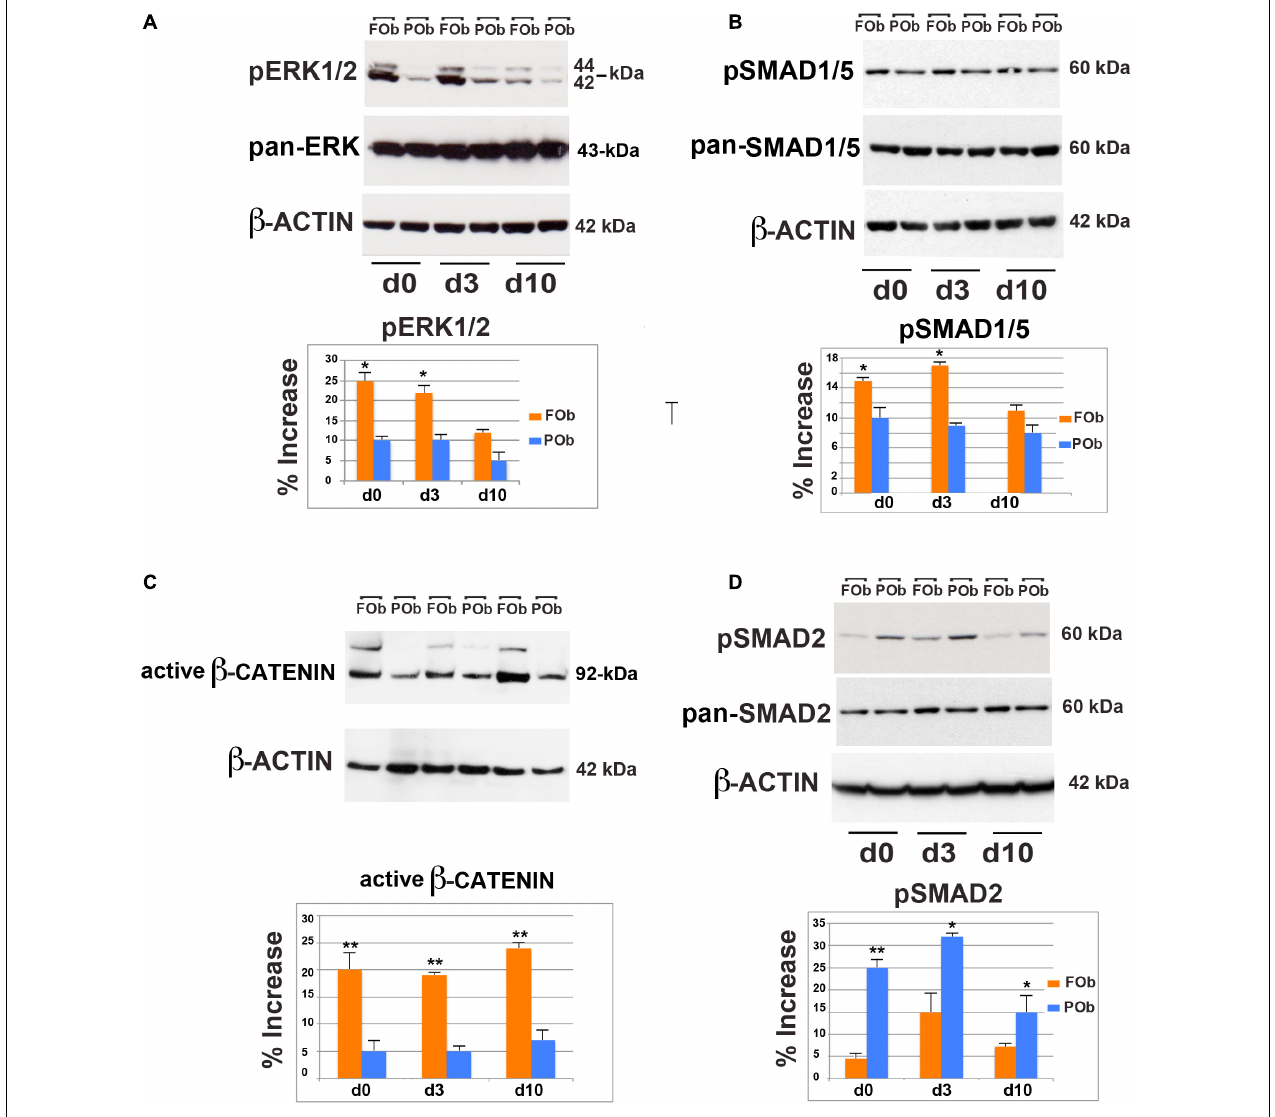
FIGURE 3 | Integration of multiple pro-osteogenic signaling pathways defines distinct active hFOb and hPOb. (A) Time-course immuno-detection of phospho-ERK1/2 (pERK1/2) in hFOb and hPOb undergoing to osteogenic differentiation showing enhanced active pERK overtime in hFOb in comparison to hPOb. Pan-ERK and β -ACTIN antibody probing the same membrane were used as internal controls for equal loading and transfer of the samples. (Bottom panel) , histogram represents the densitometric analysis of electrophoresis bands using the Image J program; the relative intensities of bands were normalized to their respective loading control and set as 100%. (B) Time-course immuno-detection of phospho-SMAD1/5 (pSMAD1/5) proteins in hFOb and hPOb undergoing osteogenic differentiation showing increased protein levels in hFOb than hPOb. Immunoblotting with pan-SMAD1/5 and β -ACTIN antibody were employed as controls for equal loading and transfer of each sample. (Bottom panel) , histogram represents the densitometric analysis of electrophoresis bands using the Image J program; the relative intensities of bands were normalized to their respective loading control and set as 100%. (C) Time-course immuno-detection of increased active β -catenin protein in hFOb is indicative of an enhanced activation of cWNT signaling in hFOb as compared to hPOb. (D) Time-course immuno-detection of phospho-SMAD2/3 (pSMAD2/3) in hFOb and hPOb undergoing osteogenic differentiation shows on the contrary of what observed for the above signaling analyses, enhanced activation of TGF- β signaling as assessed by high levels of pSMAD2/3 in hPOb then hFOb. (Bottom panel) , Immuno-detection of pan-SMAD2/3 and β -ACTIN was used as internal controls as described above (A,B) . (Bottom panel) , histogram represents the densitometric analysis of electrophoresis bands using the Image J program; the relative intensities of bands were normalized to their respective loading control and set as 100%. Values: ∗ p ≤ 0.05, ∗∗ p ≤